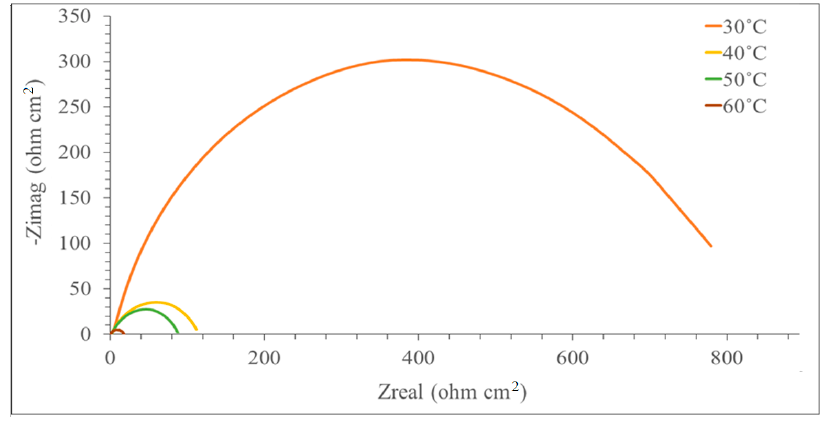
Figure 2. Nyquist plot for mild steel with 0.5 mM of the inhibitor in 1N H 2 SO 4 at various temperatures.